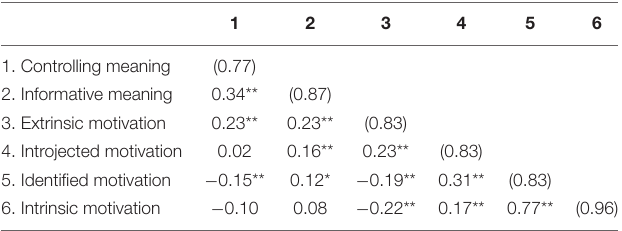
TABLE 7 | Correlations and reliability coefficients along the diagonal for the variables in Study 2 ( N =